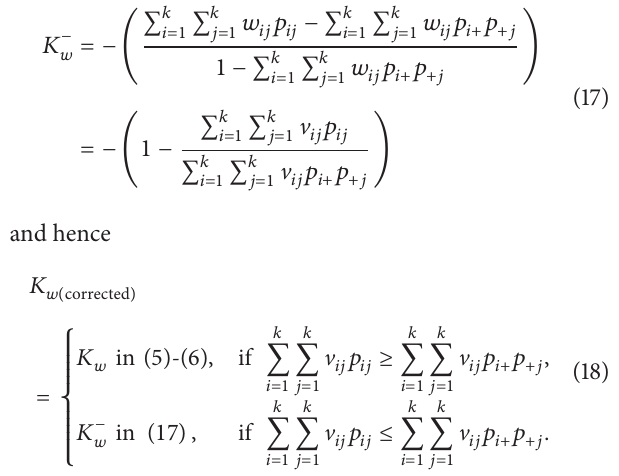
𝑤 𝑝 𝑝 ∑ 𝑘 ∑ 𝑘 𝑖𝑗 𝑖+ +𝑗 and with the sets of weights 𝑖=1 𝑗=1